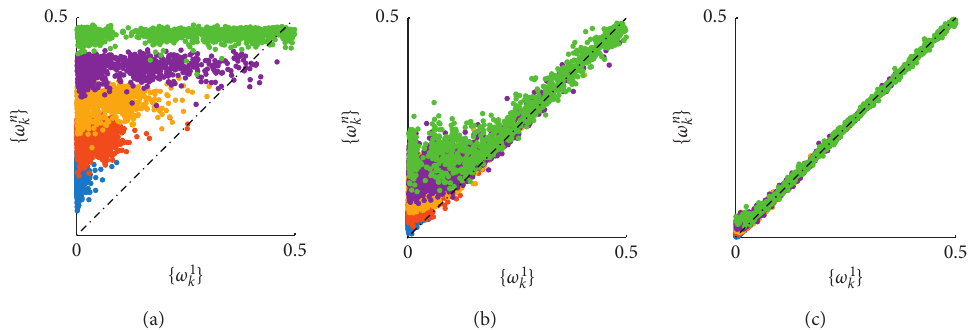
􏼈 􏼉 versus the converged center frequencies ω n k